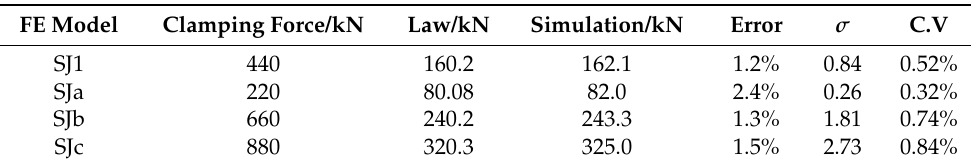
Table 6. The comparison of the friction force of the finite element simulation with different clamping force of bolts.